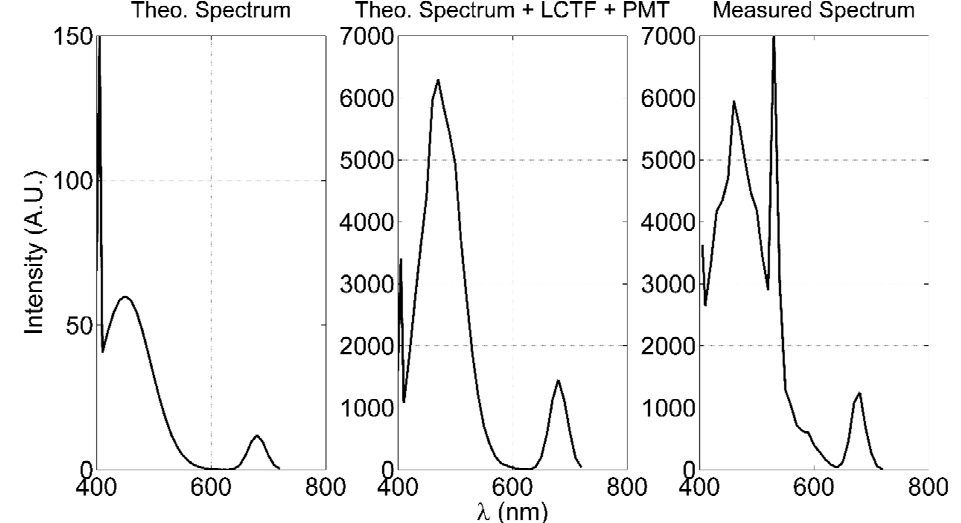
Figure A3. LCTF transfer function test. From the left: the theoretical fluorescence water spectrum; the convolution between the theoretical spectrum and the LCTF transfer function, as shown in Figure 2 of the main